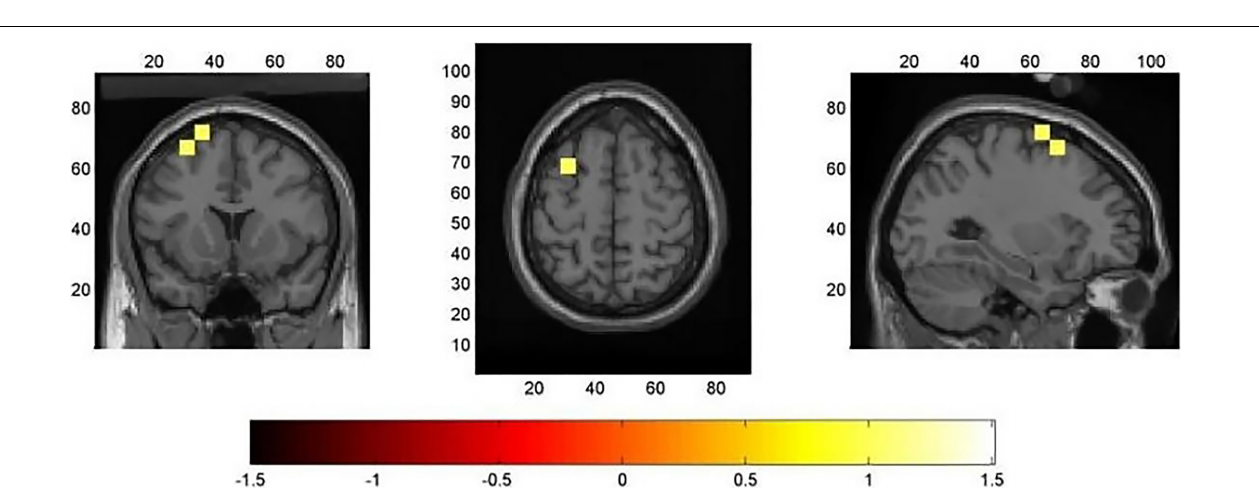
FIGURE 3 | Head plots in low and high easy of learning (EOL) judgments. (A) Low EOL judgment head plots. (B) High EOL judgment head plots. Stimulation applied at “0.0 ms” time point (stimulus onset).